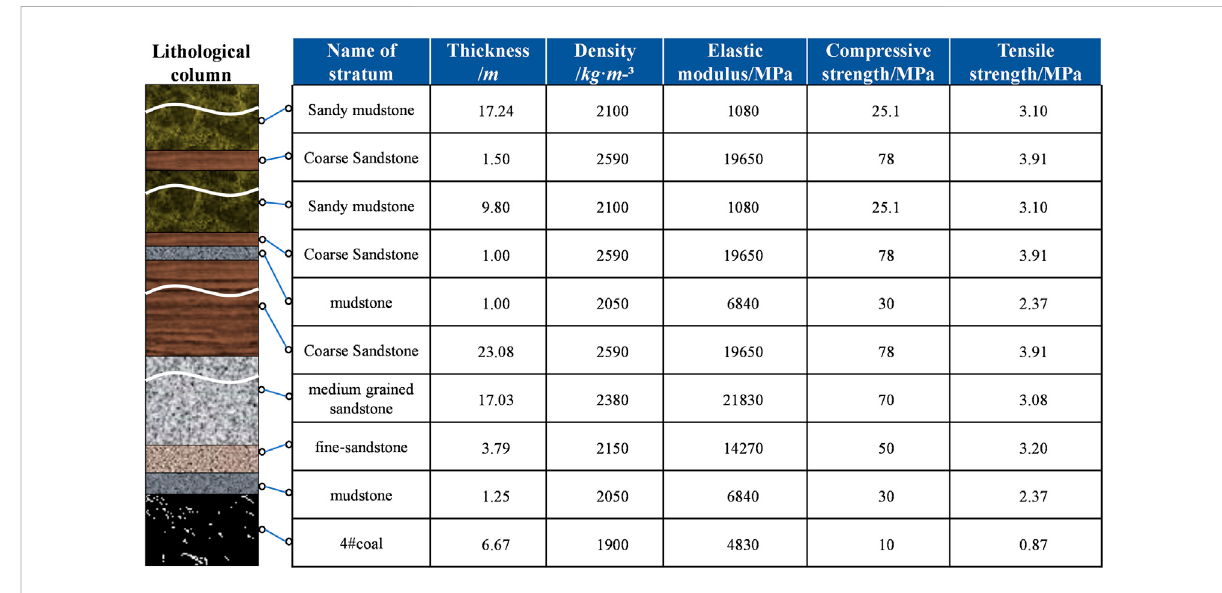
FIGURE 9 Mechanical parameters of overlying rock layers in three panels.